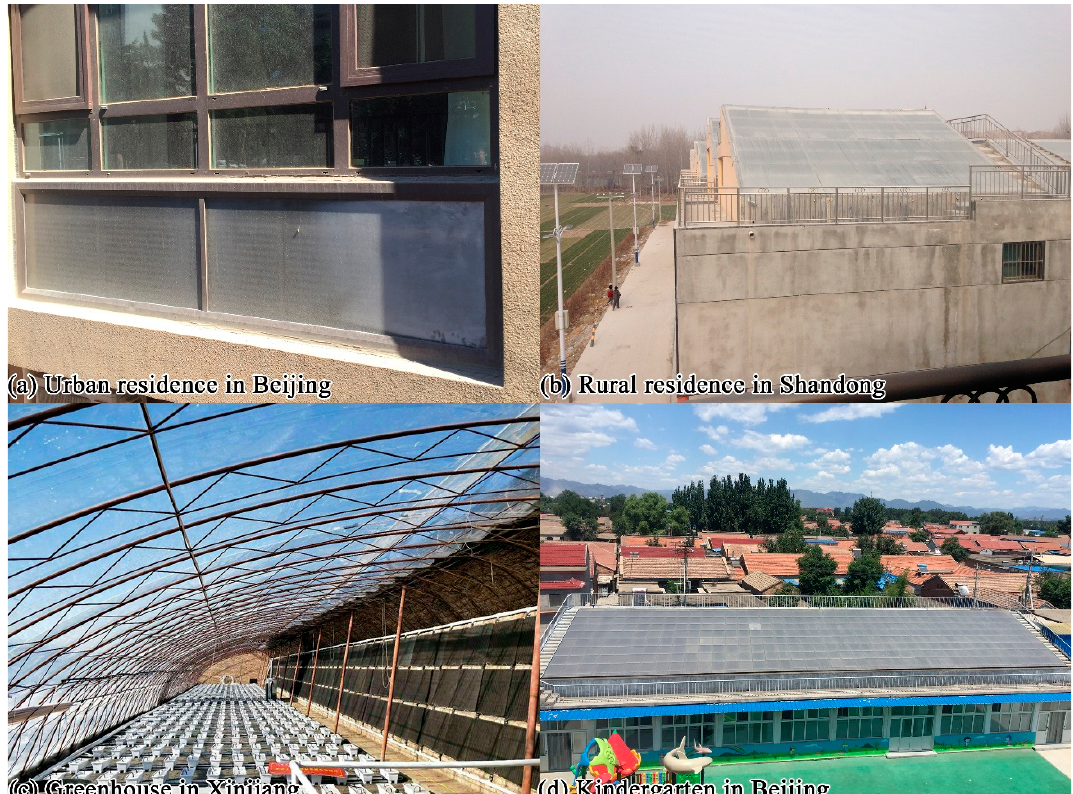
Figure 3. Construction projects using VTBC collectors.